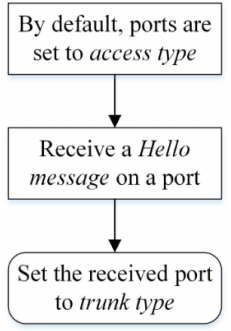
Figure 10. The process of setting port types for